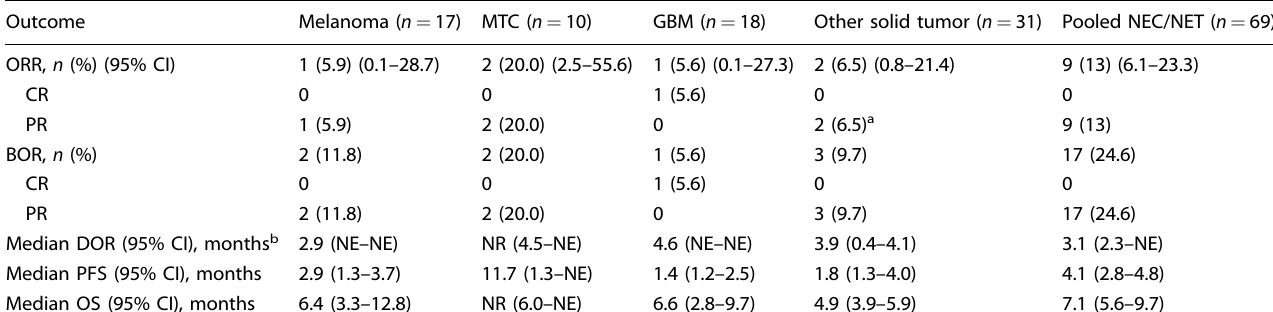
Table 4. Ef fi cacy at the 0.3-mg/kg